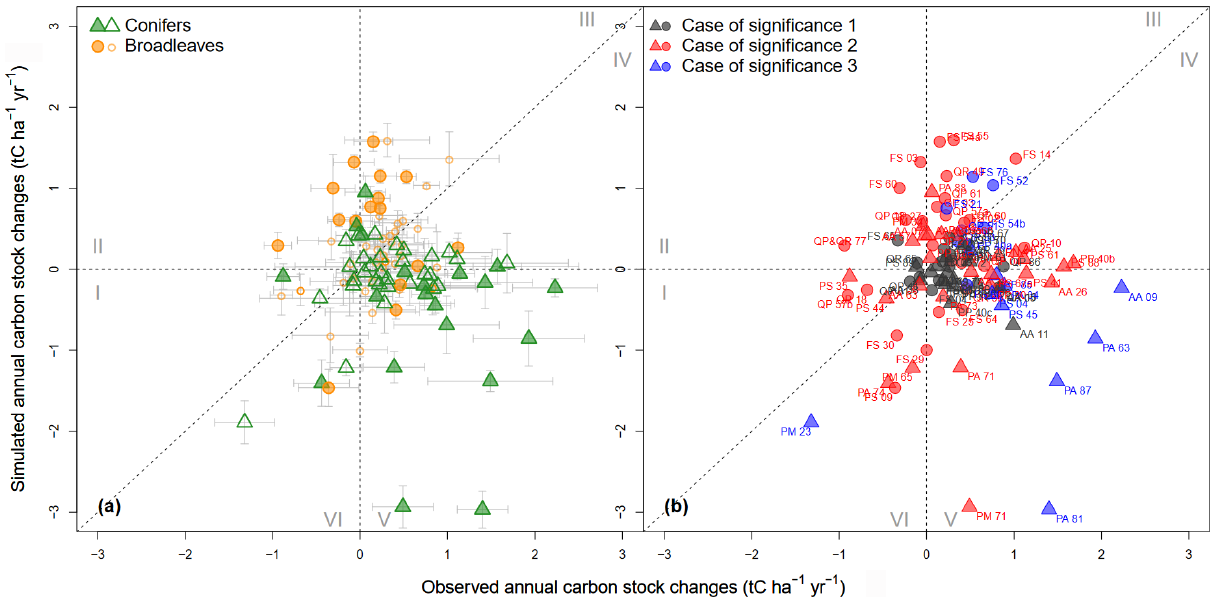
Figure 3. Comparison between simulated and observed changes in annual carbon stocks (ACCs; in tCha − 1 yr − 1 ). Circles and triangles represent sites dominated by broadleaves and conifers, respectively. The partial steady-state assumption was used when initializing CS quality to 1.0m in depth. The fine-root-to-foliage ratio for broadleaves and conifers is 1.0. To facilitate readability, Roman numerals (I–VI) denote the six zones in which data points are distributed. In (a) , error bars represent standard errors; hollow and filled points represent non-significant and significant differences, respectively, between simulated and observed ACCs according to the t test (at a 95% confidence interval). In (b) the case of significance is as follows: 1 – no significant difference from 0 for either observed or simulated ACC; 2 – a significant difference from 0 for either observed or simulated ACC; and 3 – a significant difference from 0 for both observed and